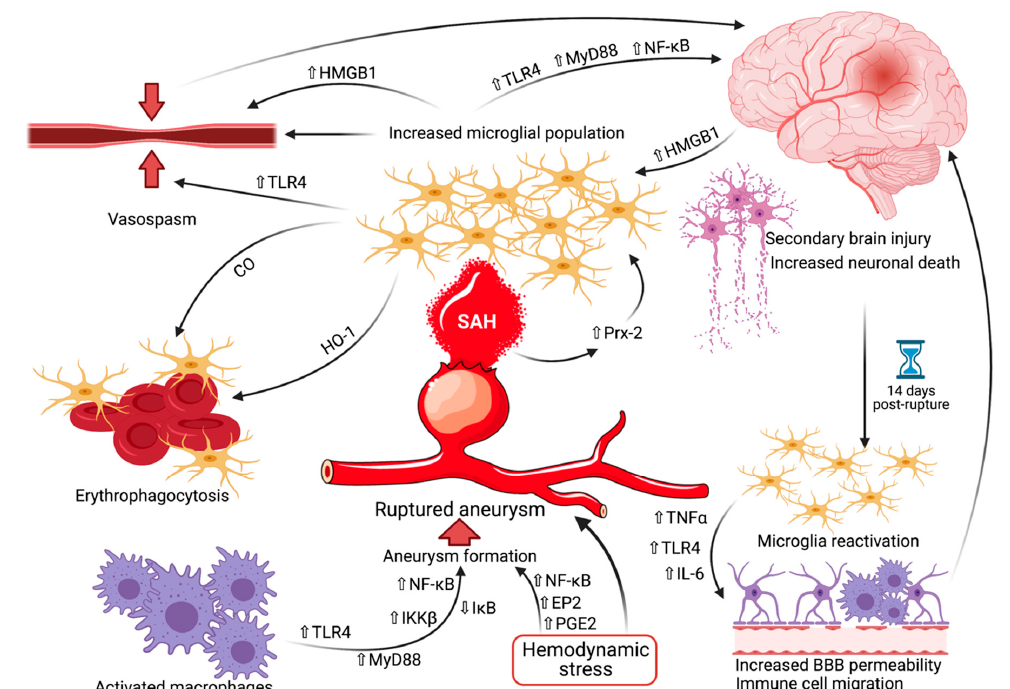
Figure 3. The pathophysiology of microglia in aneurysmal rupture. Activated macrophages in conjunction with hemody- namic stress lead to the formation of an intracranial aneurysm via pathways involving TLR4, MyD88, IKK β , I κ B NF- κ B, PGE2, and EP2. Hemodynamic stress will also eventually result in aneurysmal rupture. Aneurysmal SAH begets an increased reactive microglial population by way of Prx-2 upregulation. The microglia then generate secondary brain injury and subsequent increased neuronal death, partially also via vasospasm. At 14 days after hemorrhage, a reactivation of the microglia occurs, inducing increased BBB permeability and immune cell migration, further propagating the secondary brain injury. On the other hand, anti-inflammatory microglia are also responsible for the erythrophagocytosis at the site of SAH, diminishing its detrimental effect on the cerebral parenchyma. A transparent upward-pointing arrow denotes upregulation, whereas a transparent downward pointing arrow signifies downregulation. Abbreviations (in alphabetical order): BBB, blood-brain barrier; CO, carbon monoxide; EP2, prostaglandin E receptor 2; HMGB1, high-mobility group